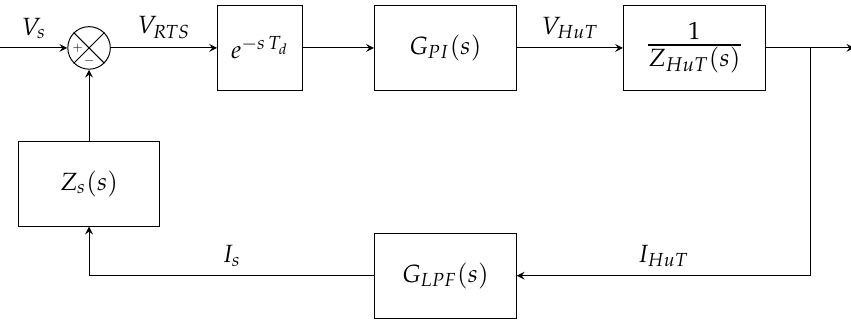
Figure 8. Block diagram of a voltage type ITM